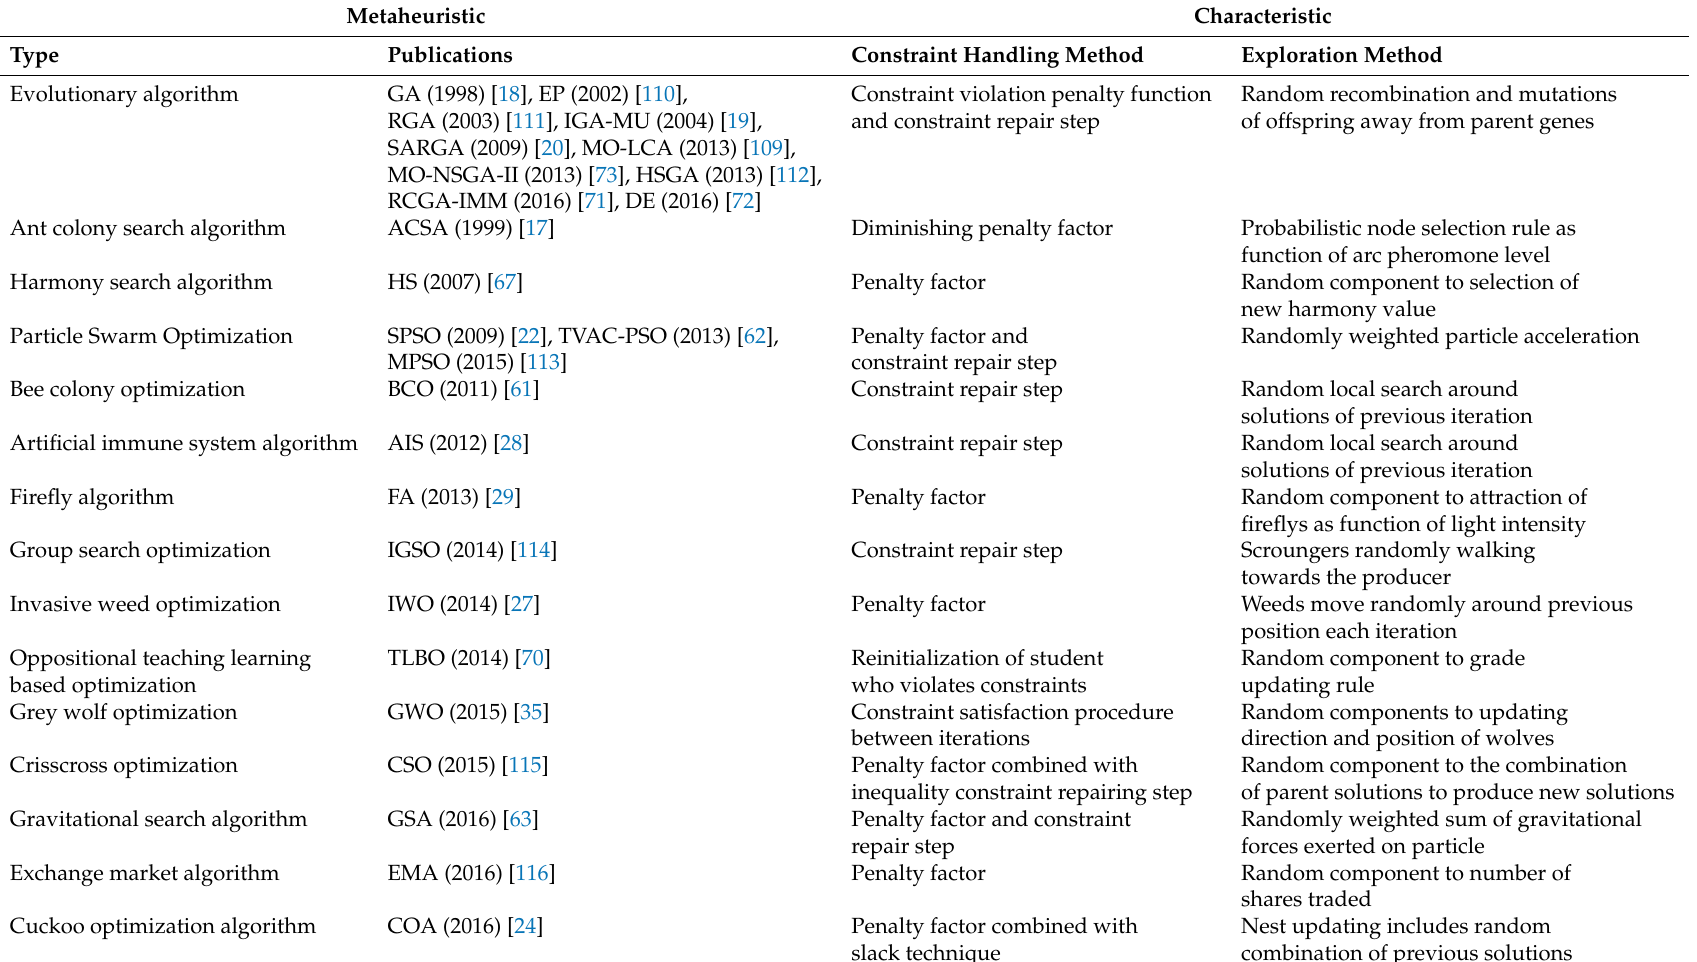
Table 4. Summary of key characteristics of past metaheuristic optimization approaches applied to the CHP-ED and